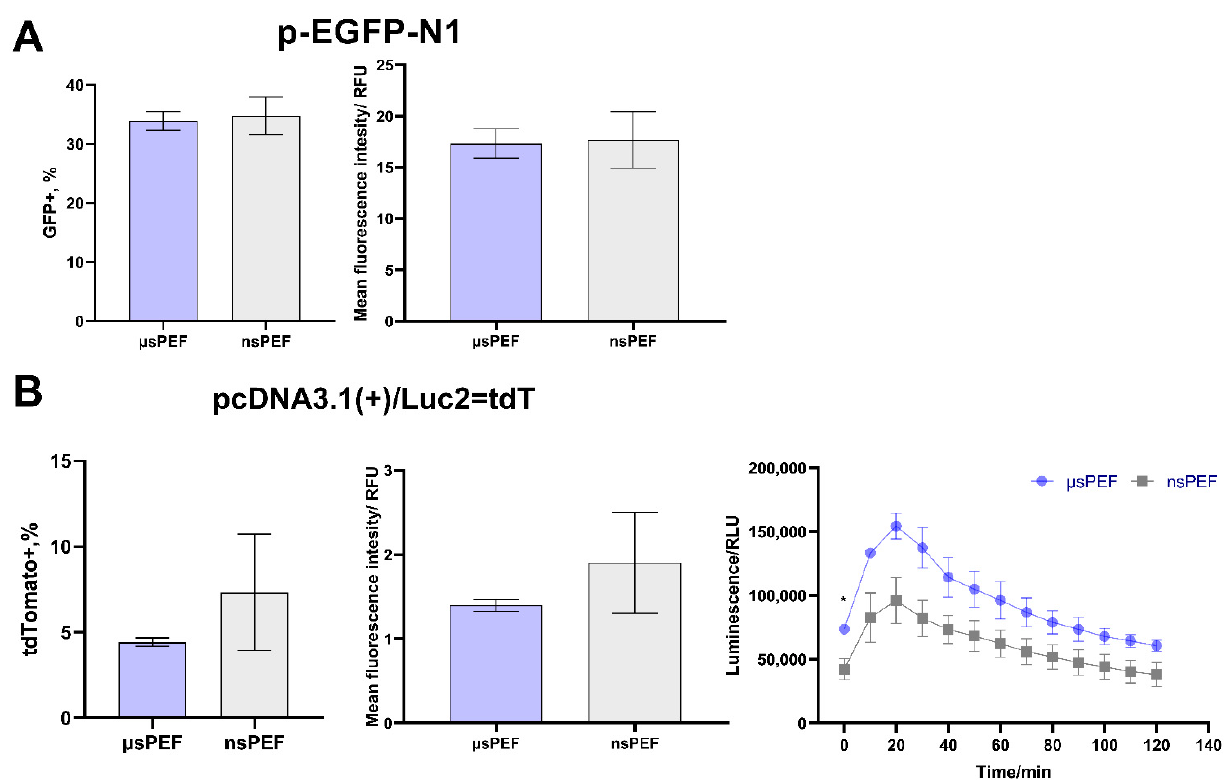
Figure 4. Transfection efficiency of murine 4T1 cell line during microsecond and nanosecond electroporation, using ( A ) pEGFP-N1 plasmid and ( B ) pcDNA3.1(+)/Luc2 = tdT plasmid. The MFI was normalized to negative control. Asterisk (*) corresponds to statistically significant differ- ence ( p <